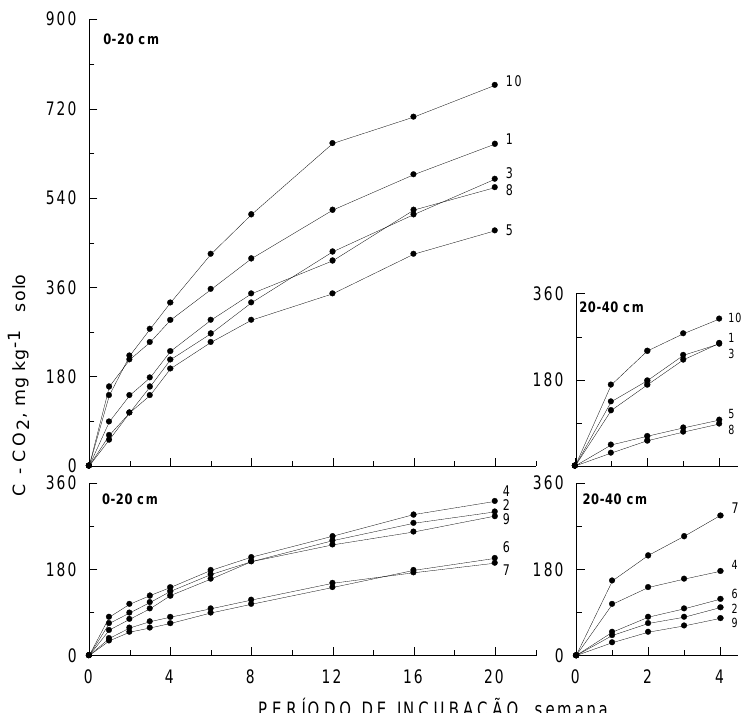
Figura 3. Mineralização acumulada de carbono (C - CO